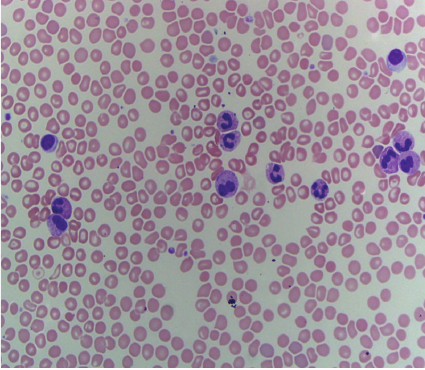
Figure 1: Blood smear showing segmented neutrophils with arrow pointing at D¨ohle bodies.